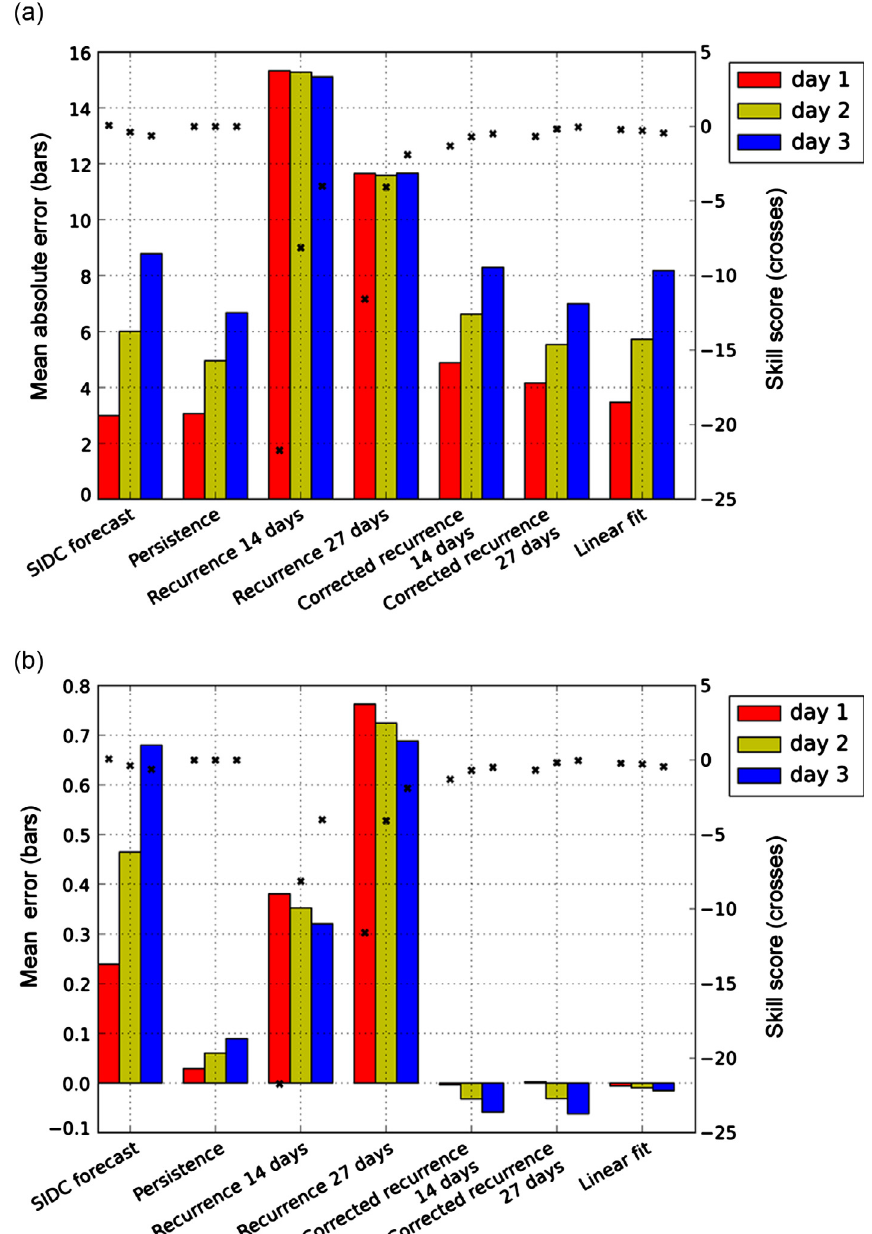
Fig. 2. Mean size of errors for the forecast of the radio flux. The plots include results for the SIDC forecast and the numerical models persistence, recurrence and corrected recurrence of 14 and 27 days and linear fit. Errors are displayed separately for days 1–3. The left vertical axis displays the error (colored bars) and the right vertical axis the skill score (Eq. (2), crosses) for each of the forecast models with respect to the persistence model as reference model. Panel (a): mean absolute error (Eq. (4)). Panel (b): mean error (Eq.